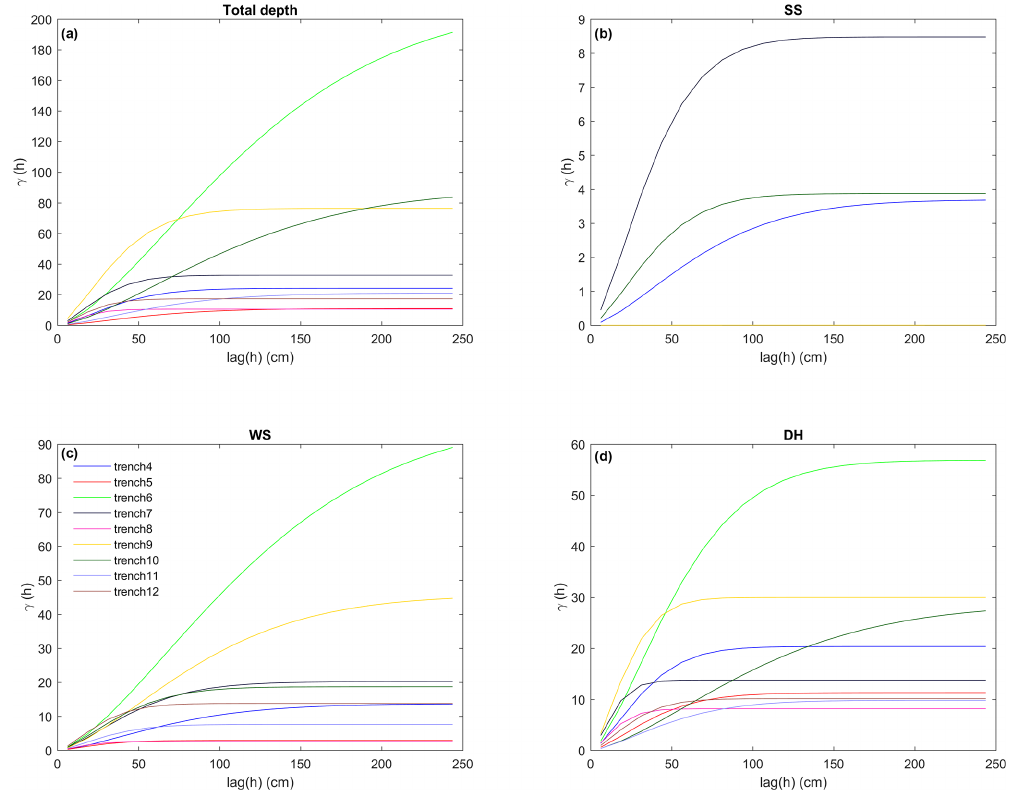
Figure 8. Semivariograms in individual trenches for (a) total snow depth, and layer thickness for (b) surface snow, (c) wind slab, and (d) depth